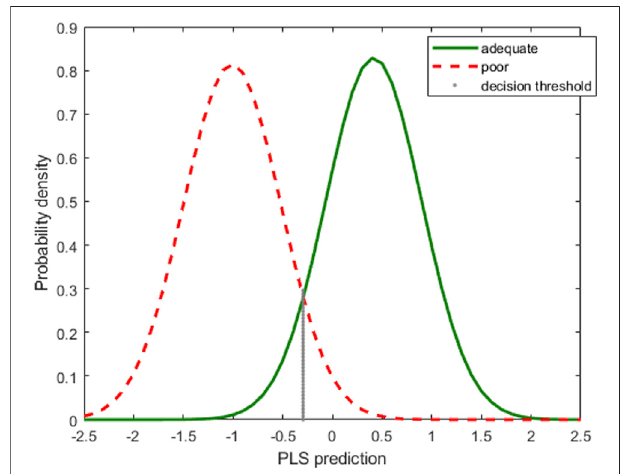
FIGURE4 | Rioja wines.ParallelCoordinates Plot for objects in the input space. In grey the wines inside the class-model with sensitivity and speci fi city 0.954. The red continuous line is x d , the remaining colored lines are for the points computed, rejected in red, and accepted in green.